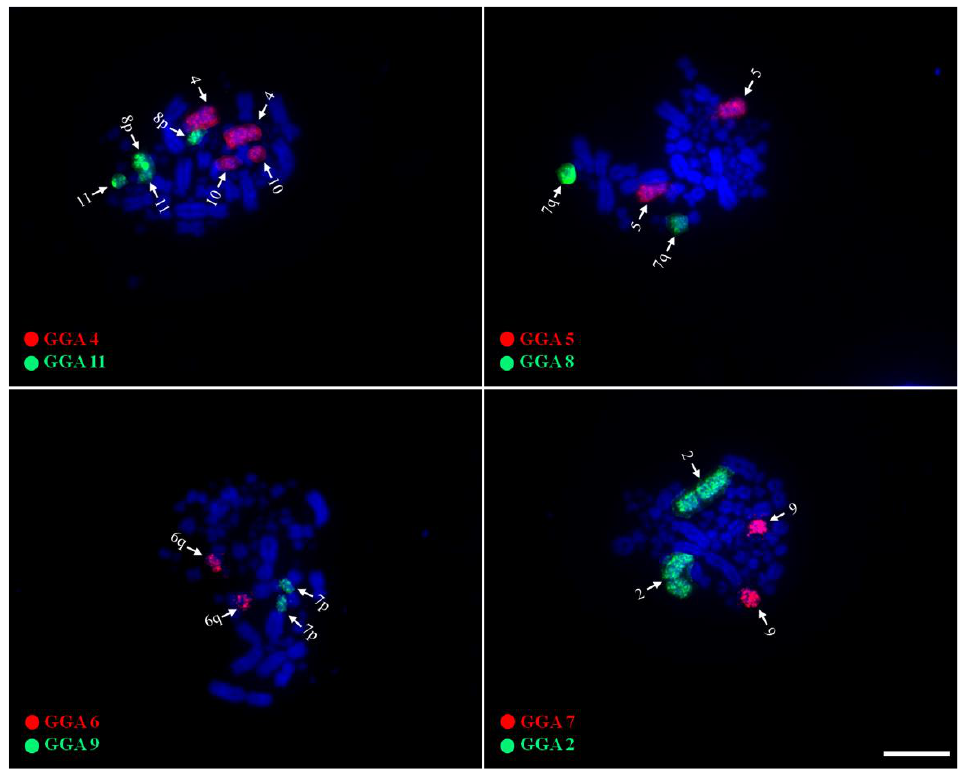
Figure 3. Representative FISH experiments using GGA whole chromosome probes on metaphase chromosomes of M. americana (bar = 10µm). Arrows indicate precisely the chromosomes by each probe.